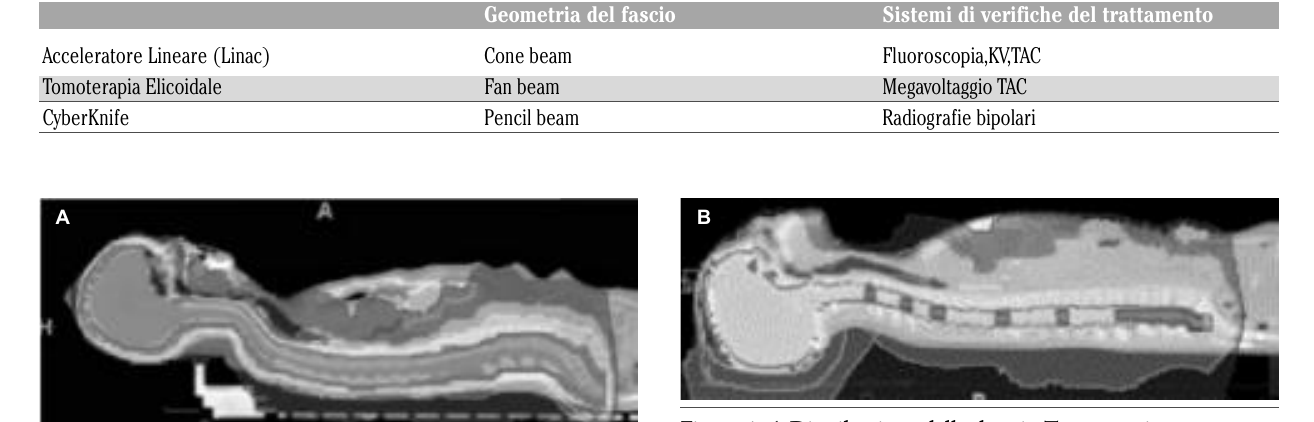
Figura 1. A Distribuzione della dose in Tomoterapia.